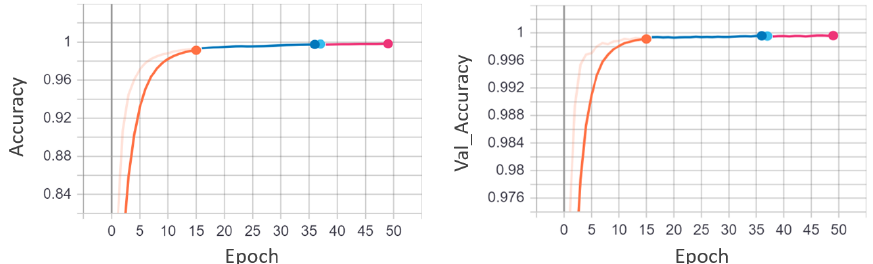
Figure 7. EADN training and validation accuracy graphs utilizing the UCF-Crime dataset. The training accuracy and the validation accuracy are plotted against the number of epochs. It is apparent from the graph that the model gets an optimal accuracy after 35 epochs. After 35 epochs, the model tends to